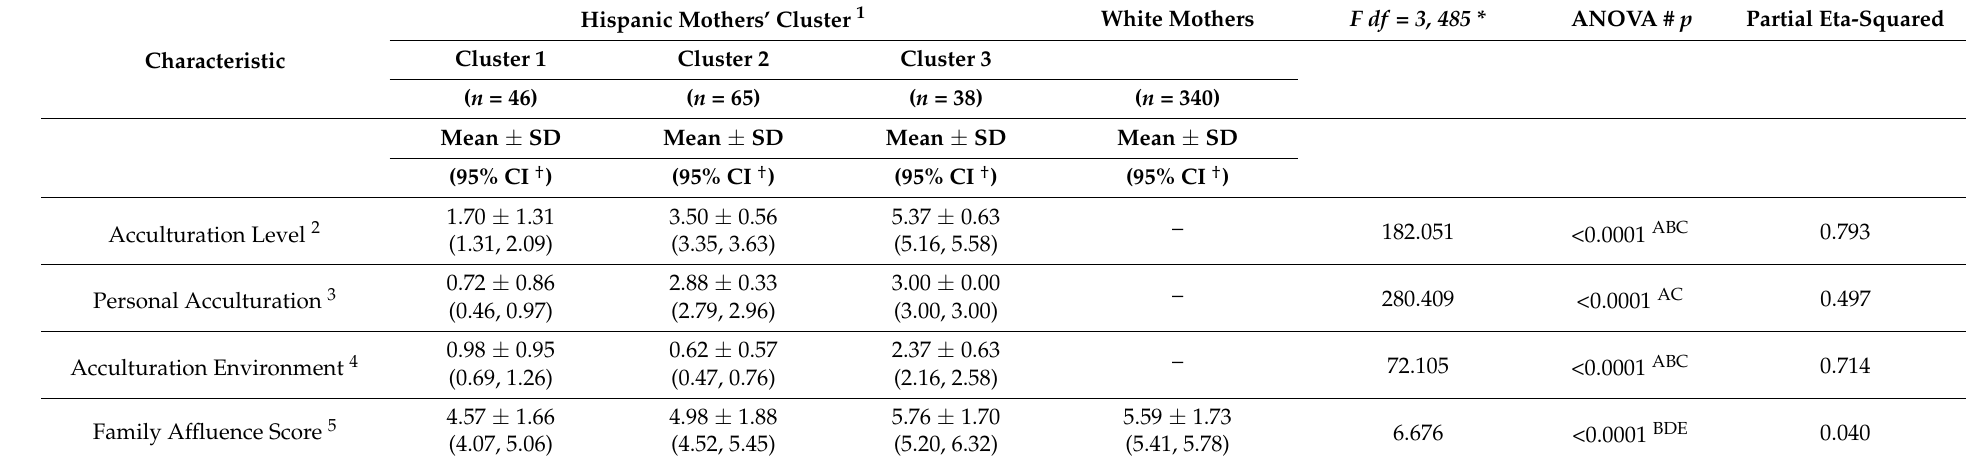
Table 1. Acculturation and Family Affluence of Mothers ( n =